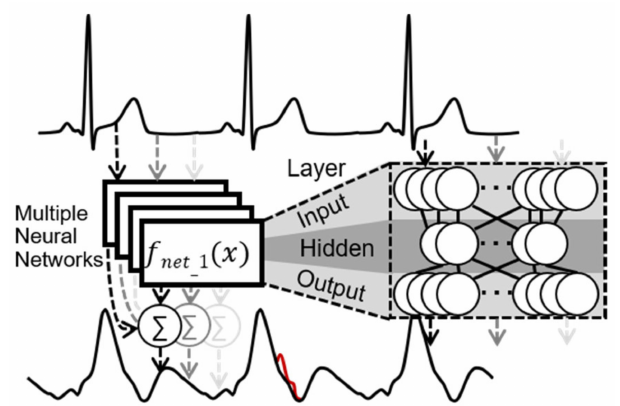
Figure 1. Principle of shallow neural network algorithm—the upper signal is the ECG (input), the lower signal is the bioimpedance signal dZ/dt